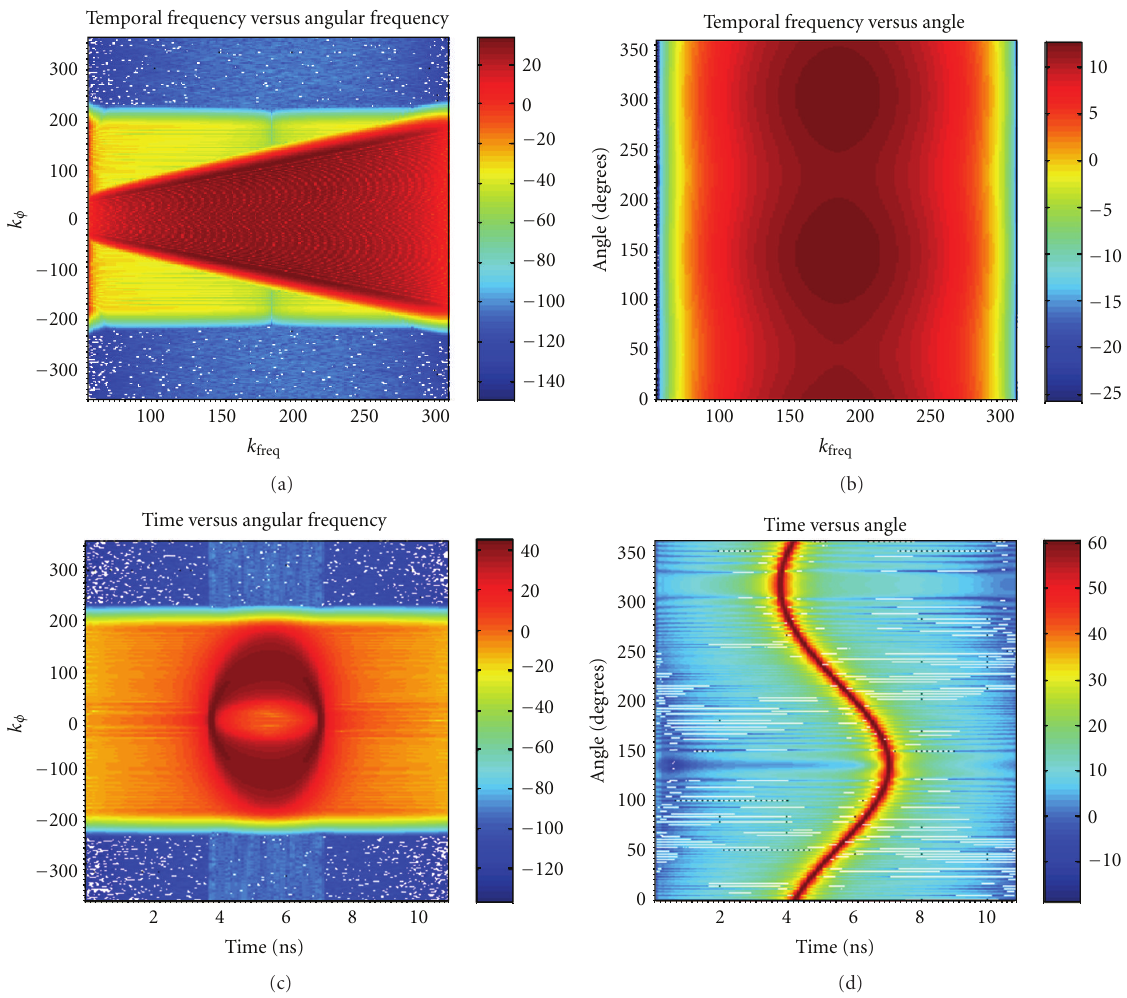
Figure 11: Four representations of data corresponding to a single simulated point target from a single bistatic antenna pair: (a) the “Fourier” domain, (b) the “raw-data” domain, (d) the “time” domain, and (c) shown for completeness but not used